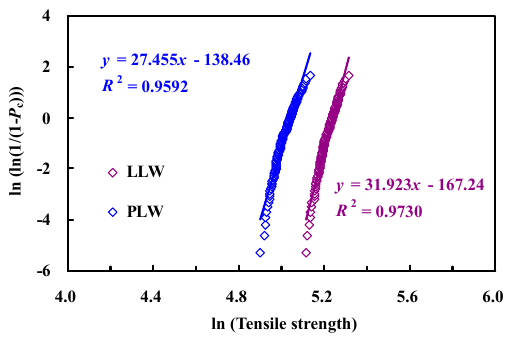
Figure 3. Weibull plots of the tensile strength of composites.